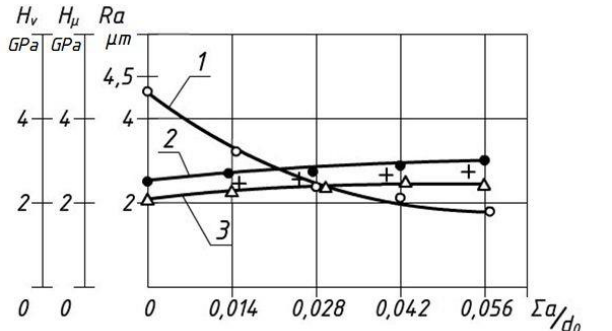
Fig. 1. The dependence of roughness ( Ra ), hardness HV , microhardness H μ50 on the total deformation when machining bushings made of steel 12H18N10T: when using solid lubricant ASM-6: 1 – Ra , 2 – H μ50 (● – on the surface, + – at